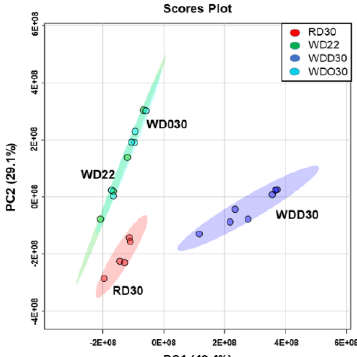
Figure 3. Principal component analysis of diet effects on hepatic lipids. All lipid data collected for this study and our previous study [52] was used in this analysis. The data included fatty acid methyl esters reported previously [52] and all membrane lipid and oxylipin data obtained by UPLC-MS/MS and HPLC-dMRM analysis, respectively. The principal component analysis was carried out using the statistical package in Metabolanalyst 4.0 [66].